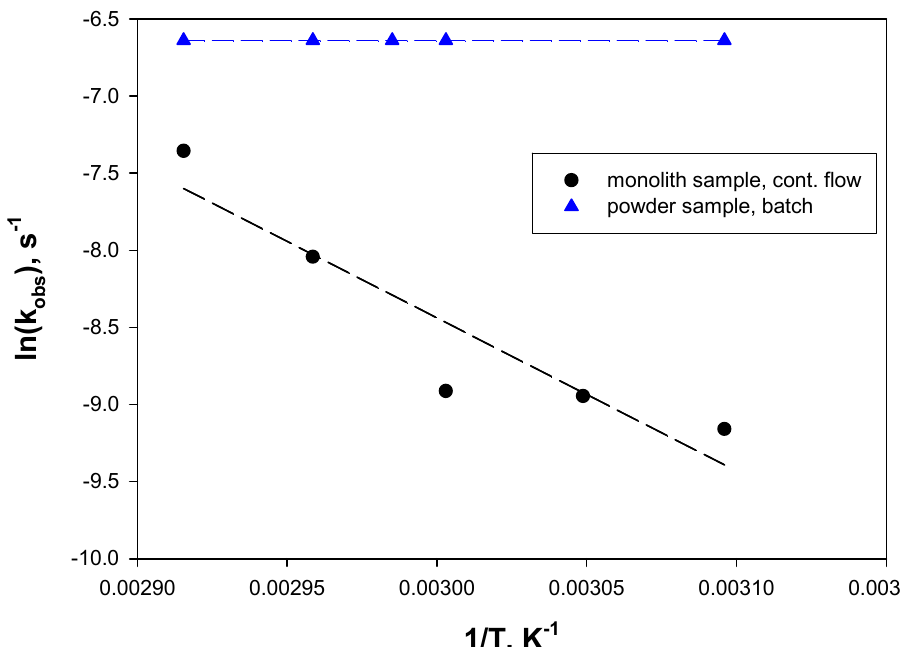
Figure 5. ln(k obs ) as a function of the reciprocal of the reaction temperature over WSN catalysts: ( ▲ ) Powder sample, batch reaction; ( • ) monolith sample, continuous flow reaction.